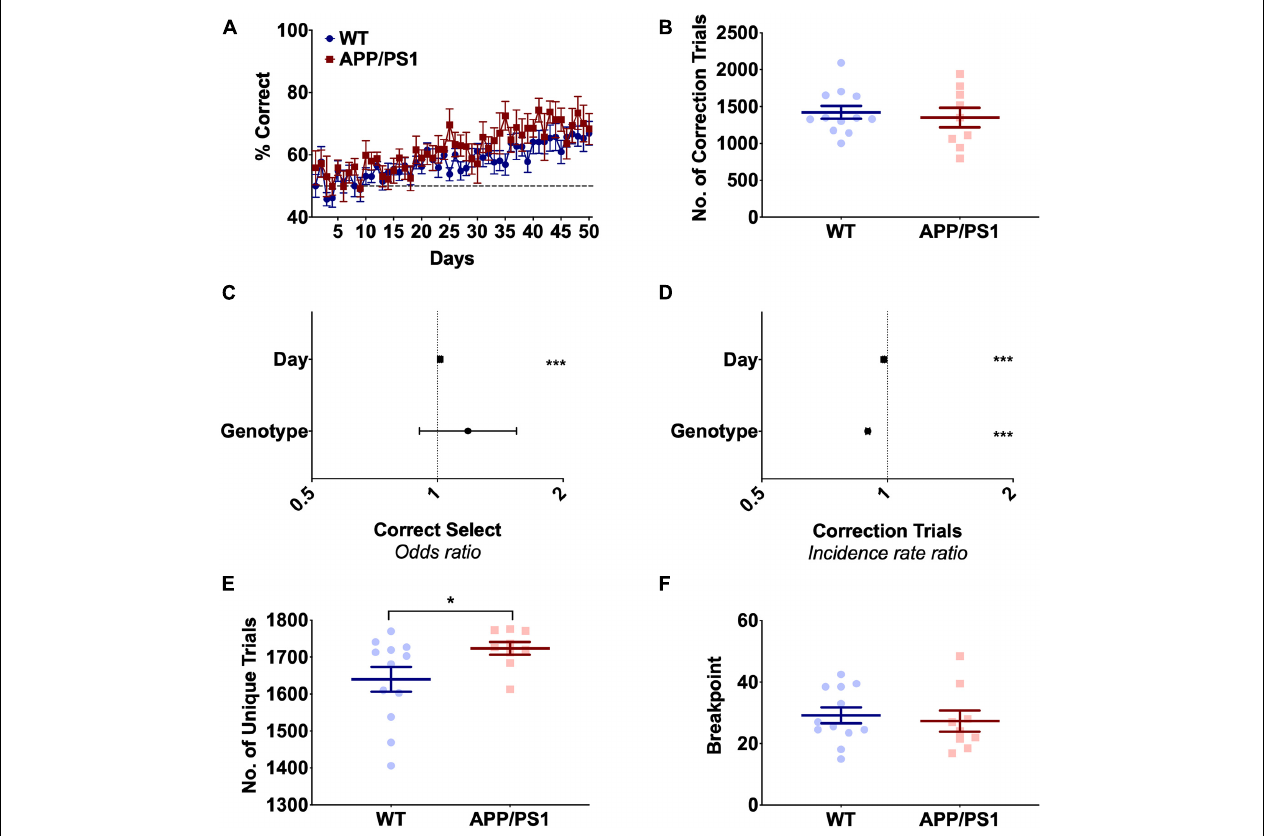
FIGURE 2 | APP/PS1 mice show no deficits in Paired Associate Learning up to 1 year of age. (A) Accuracy over 50 days of PAL in 9- to 12-month-old mice, showing no significant effect of genotype. (B) APP/PS1 and WT mice performed similar numbers of correction trials during PAL. (C) Odds of correct selection in PAL was increased by day but unchanged by genotype. (D) Incidence rate ratio of correction trials in PAL was decreased by both day and APP/PS1 genotype. (E) APP/PS1 mice performed significantly more unique trials than WT mice over PAL training. (F) APP/PS1 and WT mice had similar breakpoints in the progressive ratio task. (A) Is presented as group mean ± SEM with over 50 days of training (B,E,F) are presented as mean ± SEM with individual animals as dots. (C,D) Are the effect size ± 95% CI, showing the effect of genotype and day on odds of correct selection and incidence rate ratio of correction trials. * p < 0.05; *** p <